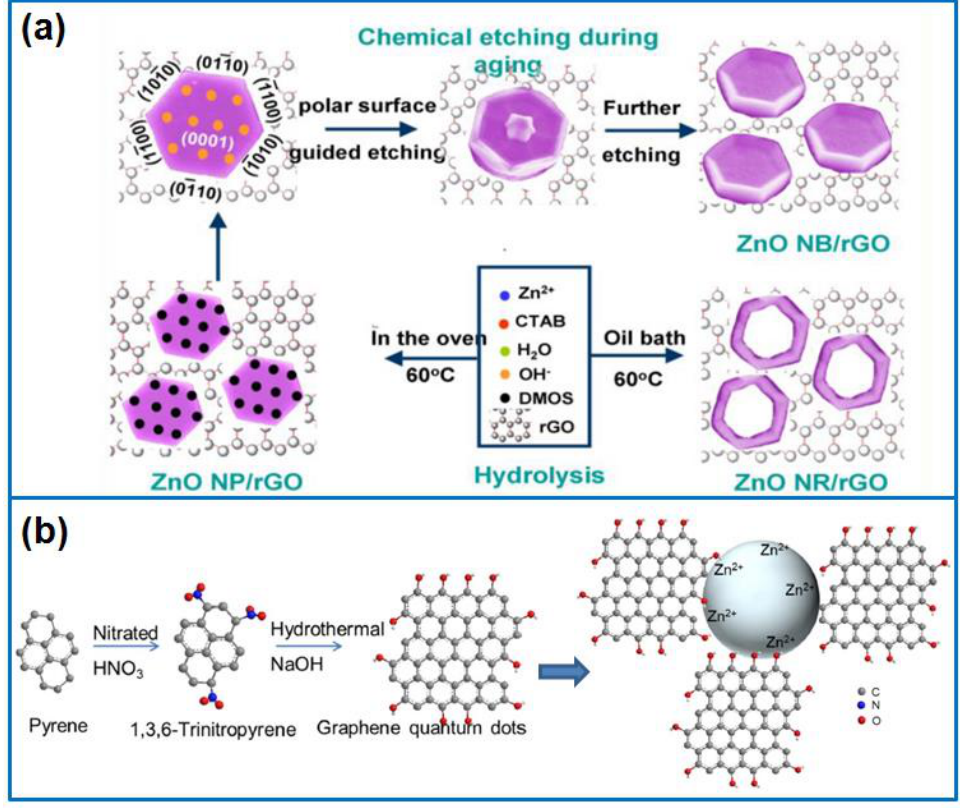
Figure 4. ( a ) Preparation of ZnO nanoring on graphene sheets; produced with permission [45]. Copyright 2017, Elsevier. ( b ) Fabrication of oval-shaped graphene/ZnO quantum hybrid; produced with permission [49]. Copyright 2017, Elsevier.